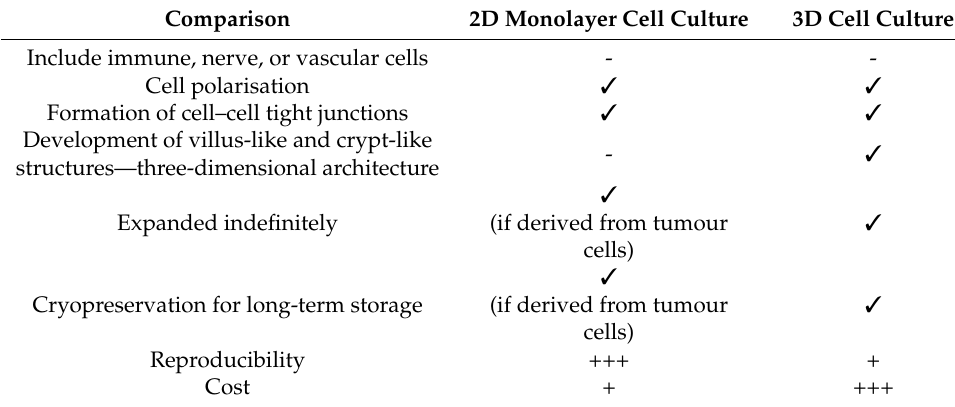
Table 1. Cont. Comparison 2D Monolayer Cell Culture 3D Cell Culture Include immune, nerve, or vascular cells Formation of cell–cell tight junctions Development of villus-like and